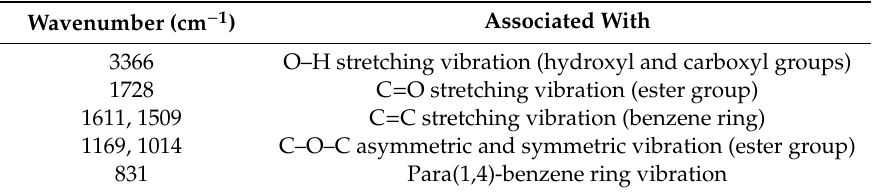
Table 1. Meaning of FTIR peaks.